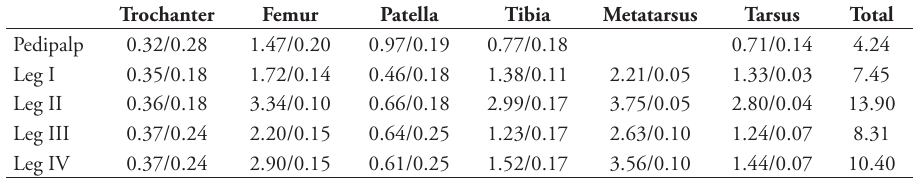
Table 1. Pedipalp and leg measurements (mm) of Lobonychium palpiplus Roewer, 1938, male, length/width. Trochanter Femur Patella Tibia Metatarsus